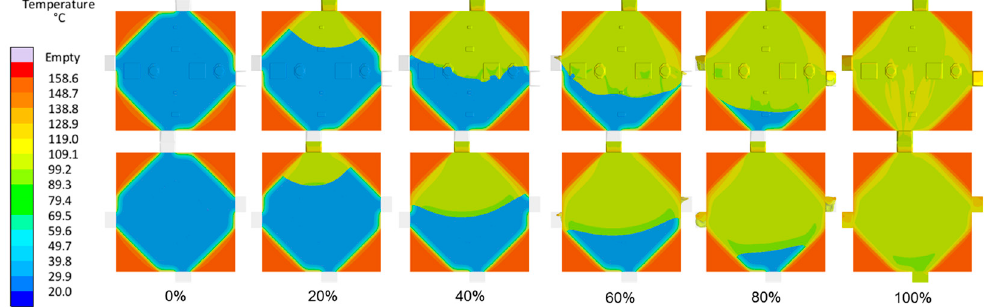
Figure 6. Simulated filling behavior (temperature scale) at different filling stages on the mounted (first row) and unmounted (second row) sides for an encapsulation thickness of 1 mm.